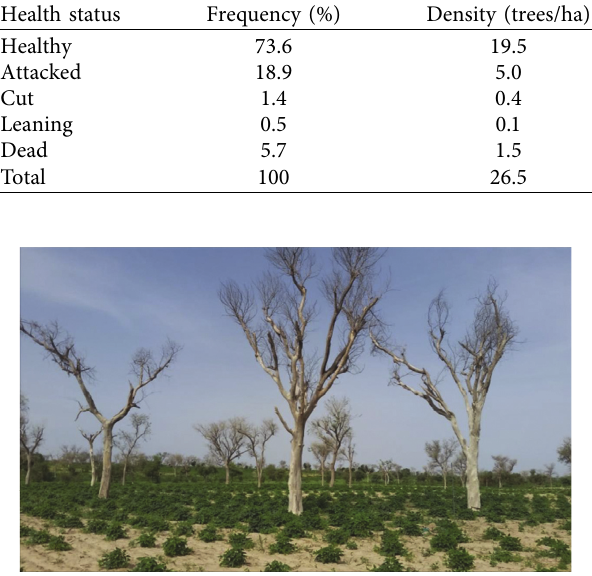
Figure 2: Dead trees of F. albida in a cowpea field in the commune of